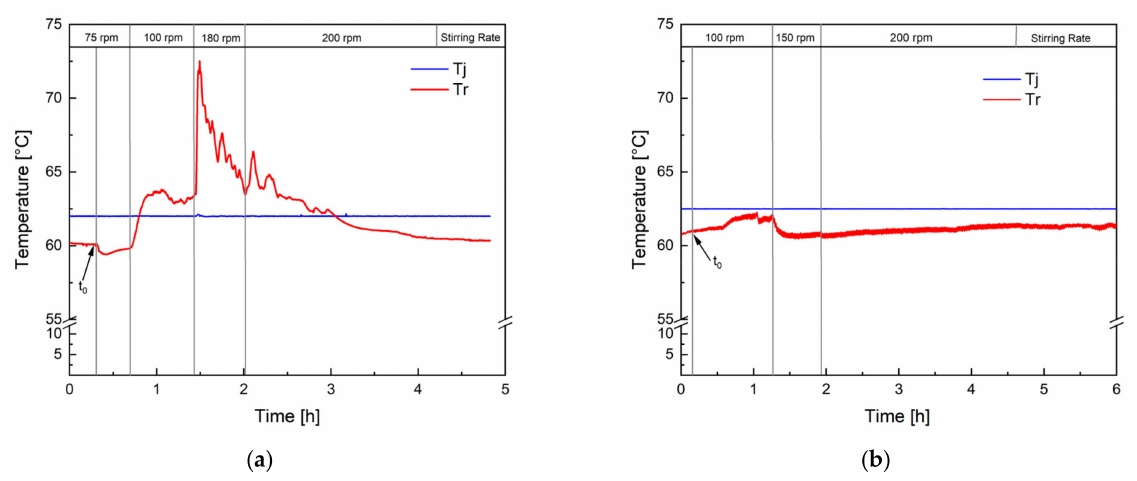
Figure 2. Temperature profile of two test reactions in a reaction calorimeter, one with insufficient mixing ( a ) and one with sufficient mixing ( b ). The reaction temperature (Tr) was monitored, and the temperature of the jacket (Tj) was kept constant at 62.5 ◦ C. t 0 indicates the initiation